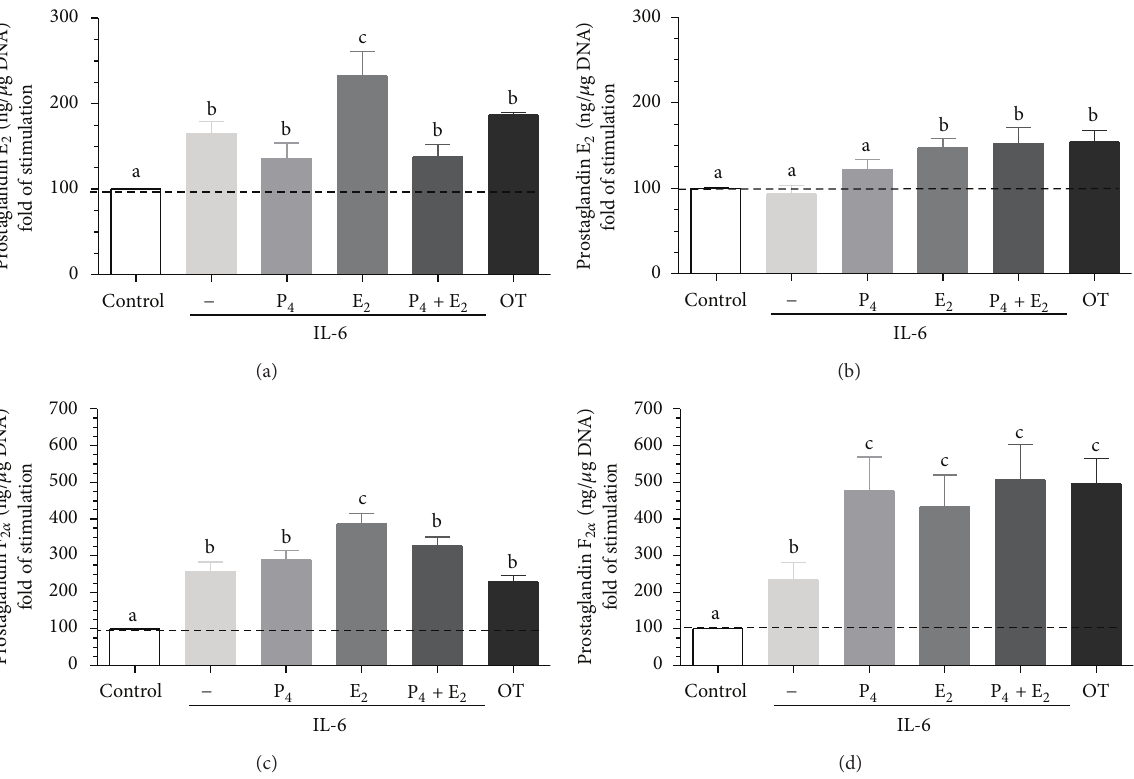
Figure 5: The effect of ovarian steroids on IL-6 stimulated PGE 2 and PGF 2𝛼 production by epithelial ((a), (c)) and stromal ((b), (d)) cells. The cells were treated with P 4 (10 −7 M), E 2 (10 −9 M), or P 4 + E 2 (10 −7 /10 −9 M) for 24 h. Then, the medium was replaced with a fresh medium and the epithelial cells were stimulated with IL-6 (10ng/mL) for 24 h. Oxytocin (OT; 10 −7 M) was used as a positive control. All values are expressed as n- fold change from control. letters “a,” “b,” and “c” indicate significant differences ( 𝑃 < 0.05 ) between groups, as determined by parametric one-way ANOVA followed by Newmann-Keuls comparison